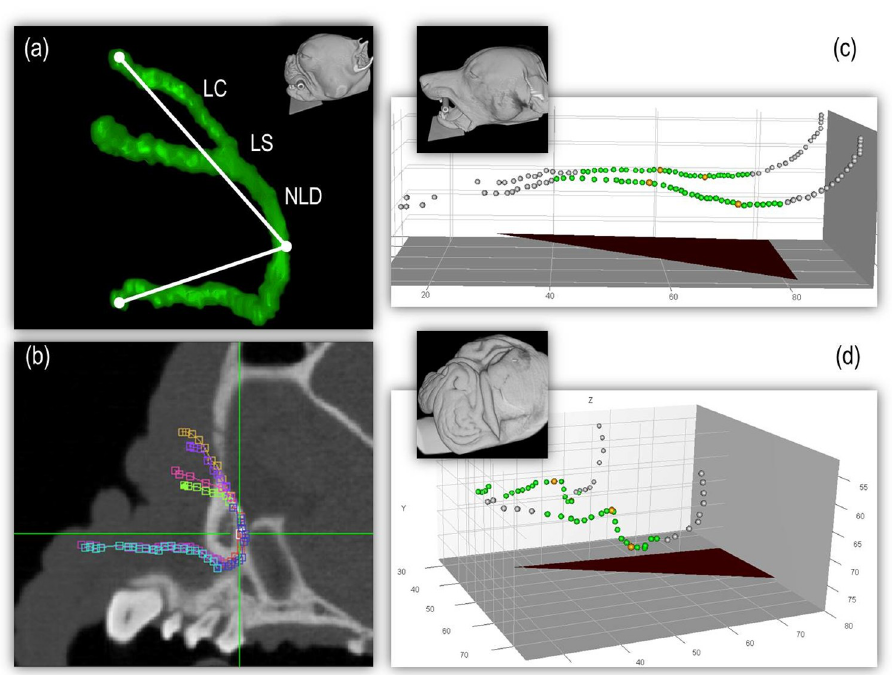
Fig 1. Methods to measure angulation, length, and slope of the nasolacrimal duct (NLD). The images depict the measurement methods used to determine the angulation, length, and slope of the NLD. The viewing perspective is represented by the heads in the picture. (a) Angulation: A 3D illustration of the complete nasolacrimal drainage system (NDS) (unilateral) is shown. Visible are the three points used for angle determination: the upper lacrimal punctum, the caudalmost point of the NLD (vertex), and the nasolacrimal ostium. LC = lacrimal canaliculi; LS = lacrimal sac; NLD = nasolacrimal duct. (b) Length: In a CT sagittal section of a Pug, the different parts of the NDS can be seen (bilateral) marked in different colors. The NDS was marked manually point by point along its entire course using the colored markers shown. The lengths of the individual segments were determined separately. All straight distances between the individual markers were then added to the total length of one segment of the NDS. (c) and (d) Slope: The picture shows the NLD bilaterally (not the entire NDS) in a three-dimensional coordinate system. The coordinates of the NLD are illustrated as dots. The triangle represents the alignment of the hard palate. The green dots show the area included in the measurement. The orange dots represent the lowest and highest points. The grayish dots are outside the area of interest. The gradient was obtained starting from the lowest point of the NLD shortly before leaving the osseous lacrimal canal. The second measuring point was the peak of its middle portion. The lowest and highest points of the NLD were determined in relation to the alignment of the hard palate (triangle), so the results were unaffected by head positioning.